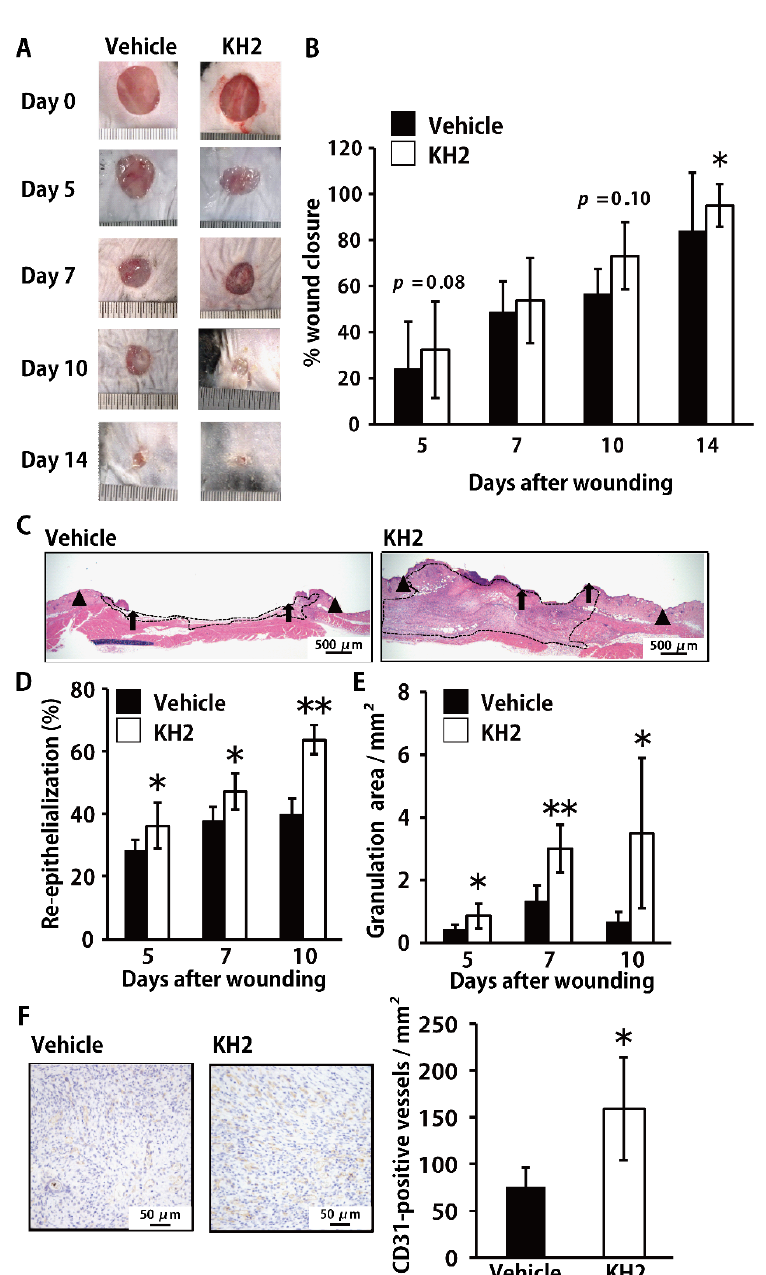
Figure 1. Effect of heat-killed KH2 administration on skin wound-healing. Wounds were created on the backs of vehicle or heat-killed KH2-treated mice. Photographs ( A ) were taken, and the percentages of wound closure ( B ) were evaluated on days 5, 10, and 14 ( n = 8–20 wounds). ( C ) Representative histological views of skin wounds on day 10 are shown. Arrowheads, arrows, and the dotted line indicate the original wound edges, re-epithelialized leading edges, and granulation area, respectively. The wound edges were determined as the border between the normal epithelium and the thick proliferative epithelium. ( D ) Time-course changes in the re-epithelialization ratio after wound creation are shown ( n = 4–6 wounds). ( E ) Time-course changes in the granulation tissue area after wound creation are shown ( n = 4–6 wounds). ( F ) Micrographs show CD31-positive cells stained with anti-CD31 antibody on day 10. The vascular density/mm 2 was determined by counting the number of positive vessels within 5 visual fields ( n = 4–6 wounds). Each column represents the mean ± standard deviation. The results are representative of at least two independent experiments. * p < 0.05, ** p < 0.01.